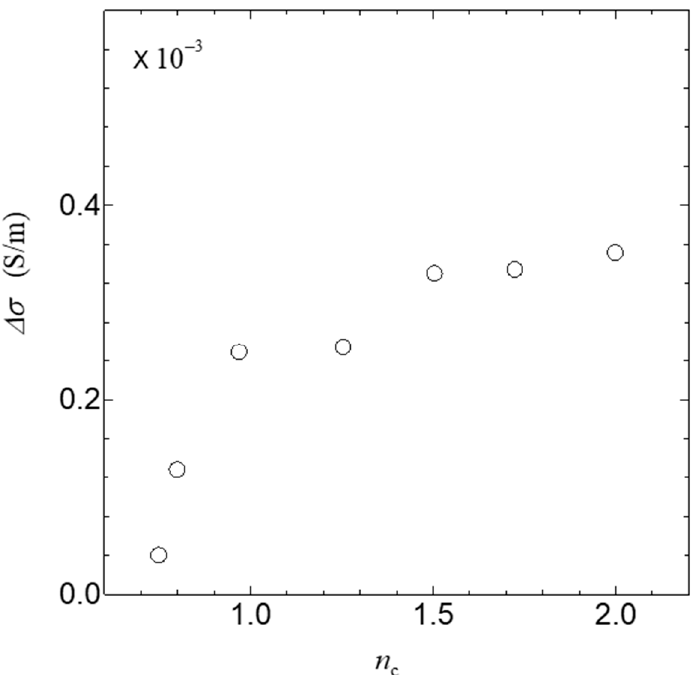
Figure 8. Relation between the hydration number n c and the value ∆ σ of proton-conductivity change by irradiating the light.